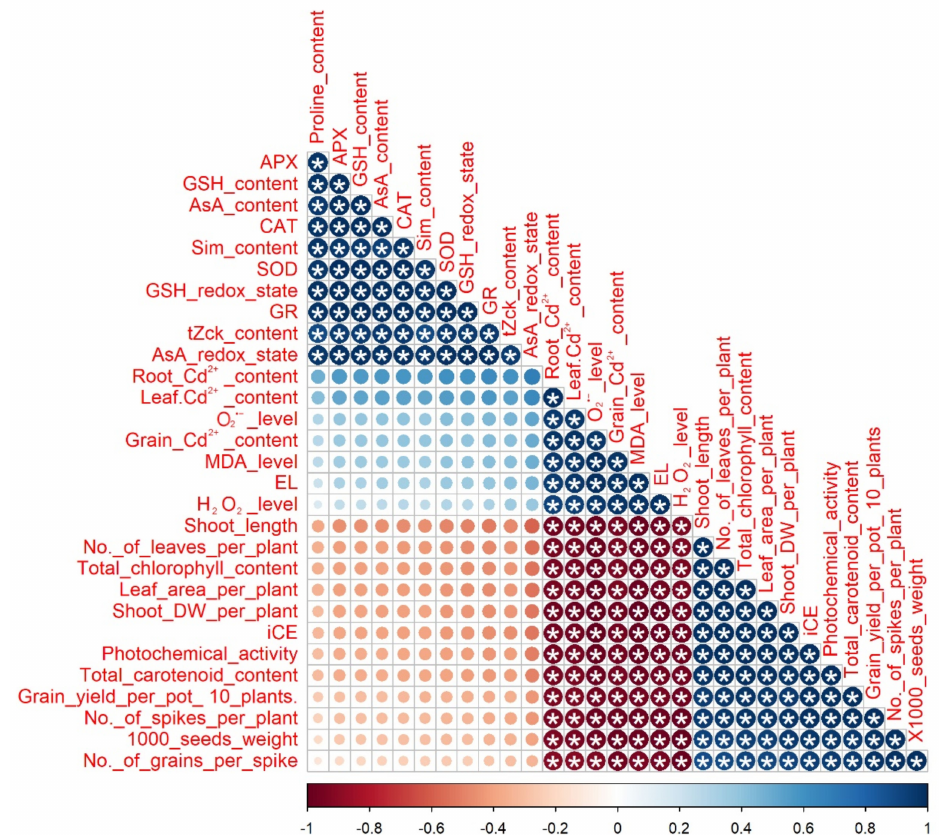
Figure 10. Pearson’s correlation analysis among the different studied parameters. The colors represent variations in the obtained data. iCE; instantaneous carboxylation efficiency, O 2 •− ; superoxide, H 2 O 2 ; hydrogen peroxide level, MDA; malondialdehyde level, EL; electrolyte leakage, Cd; cadmium content, AsA; ascorbate level, GSH; glutathione, Sim; silymarin, t Zck; trans -zeatin-type cytokinin contents, SOD; superoxide dismutase, CAT; catalase, APX; ascorbate peroxidase and GR; glutathione reductase. * p ≤